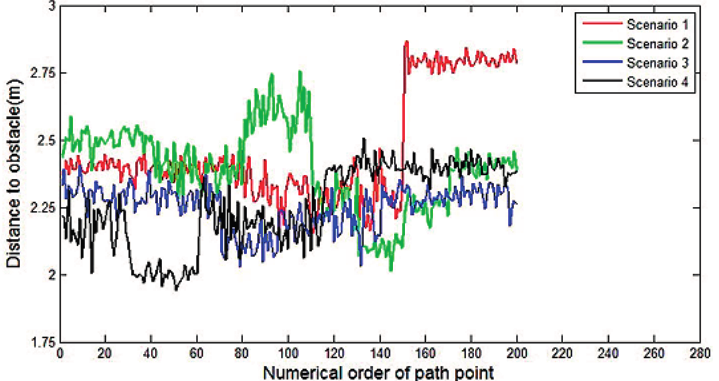
Figure 15. The distance to the nearest obstacle recorded in different